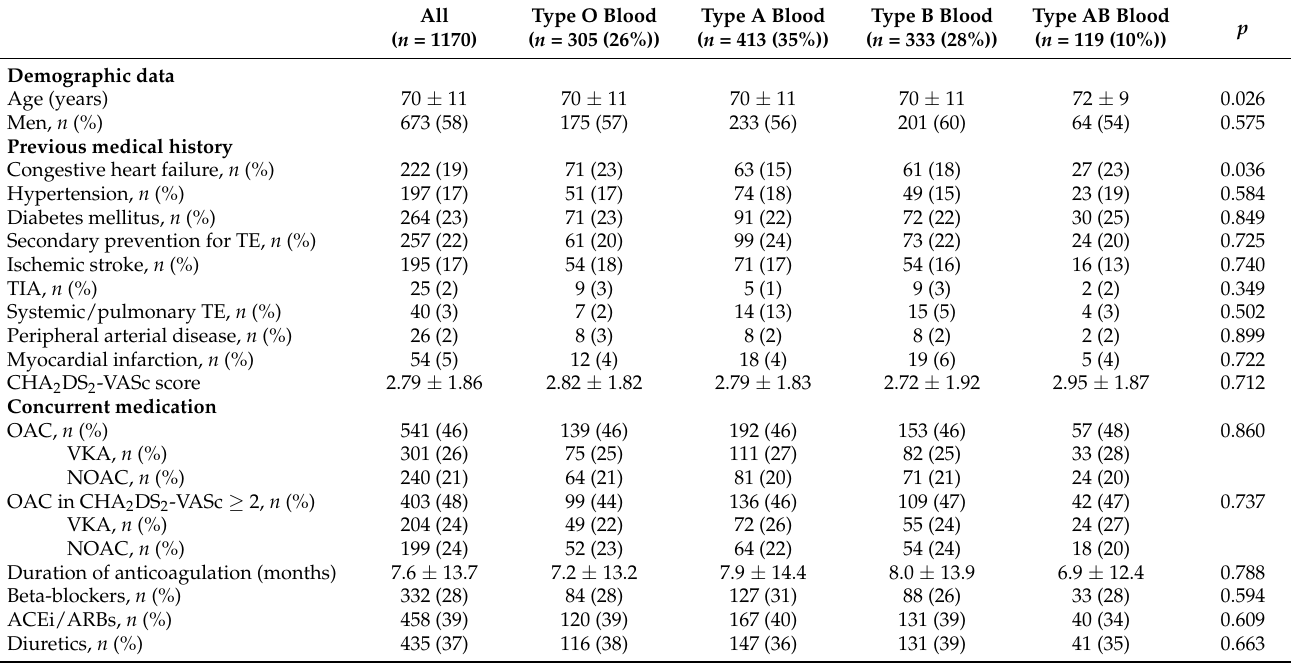
Table 1. Baseline characteristics and outcomes of the total cohort.